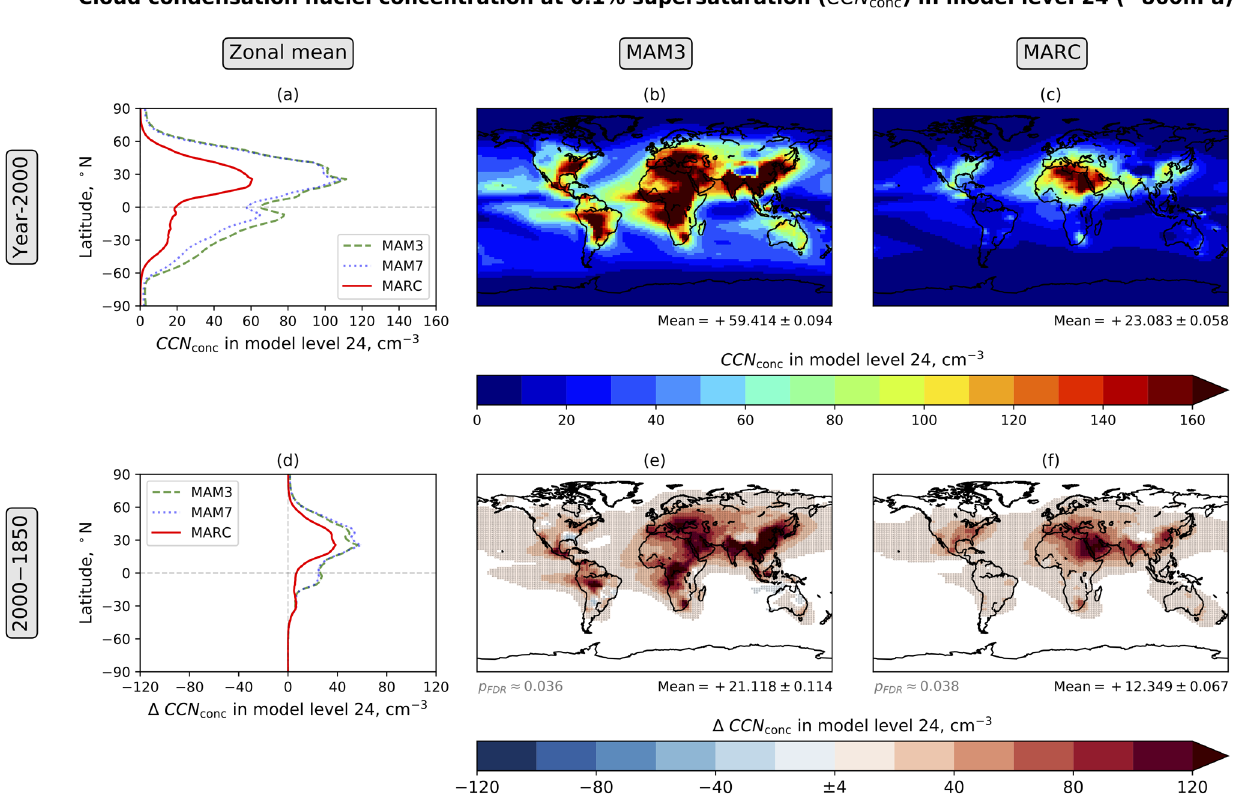
Figure 10. Annual mean cloud condensation nuclei concentration at 0.1% supersaturation (CCN conc ) in model level 24 (in the lower troposphere). The figure components are explained in the Fig. 2 caption. Corresponding results showing CCN conc near the surface and in the mid-troposphere are shown in Figs. S1 and